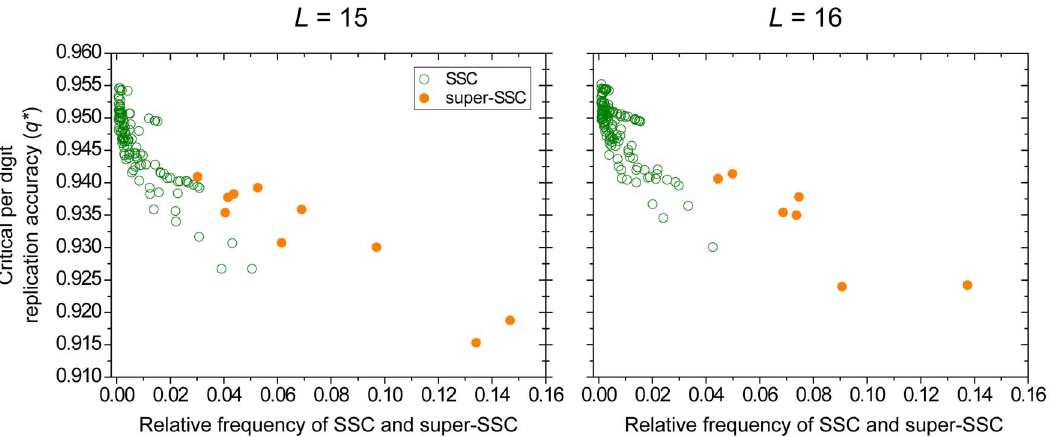
Figure 1. Error thresholds of secondary structure classes (SSCs). The graphs depict the critical per digit replication accuracies (error thresholds) as a function of the frequency of sequences belonging to an SSC among all possible structures of L ~ 15 (left) and L ~ 16 (right). Open circles represent individual SSCs, solid circles represent super-SSCs (SSSC) that merge structures that only differ in the flanking single-stranded regions. Only SSCs are included that cover at least 0.1% of the total sequence space.